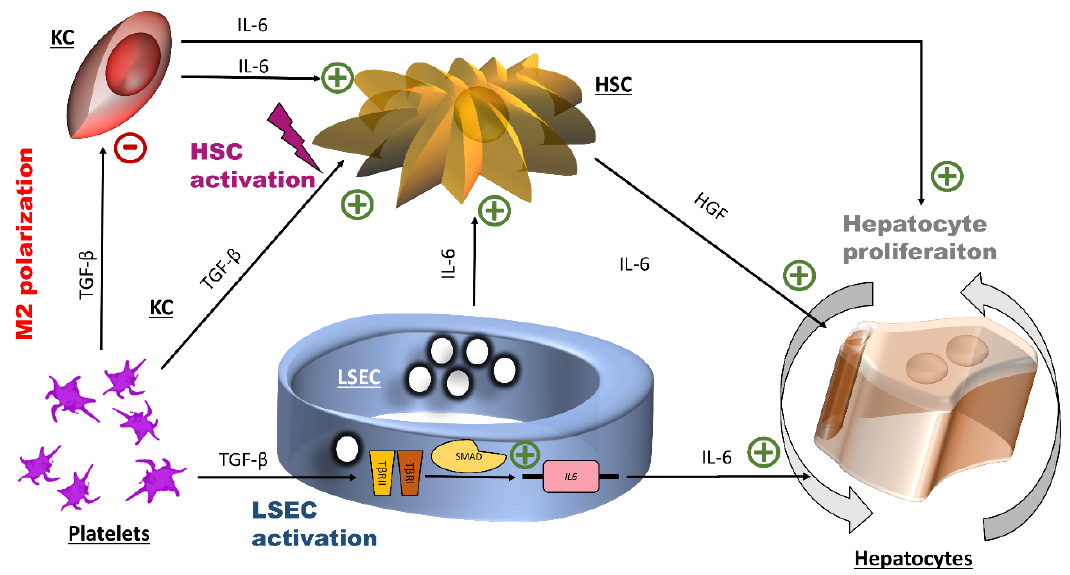
Figure 6. Potential e ff ects of transforming growth factor β 1 and interleukin-6 at the early stage of liver regeneration. The initial action of platelet TGF- β 1 is the induction of the expression of the IL-6 gene by LSEC, probably through the canonical small mothers against decapentaplegic SMAD transcription factor complex. IL-6 promotes hepatocyte proliferation. Additionally, platelets TGF- β 1 is connected to inflammation through its e ff ects on hepatic stellate cells (HSC) (cell activation) and on Kuppfer cells (KC) (M2 polarization). HGF: hepatocyte growth factor, HSC: hepatic stellate cells, IL-6: interleukin-6, LSEC: liver sinusoidal endothelial cells, TGF- β 1: transforming growth factor β 1.